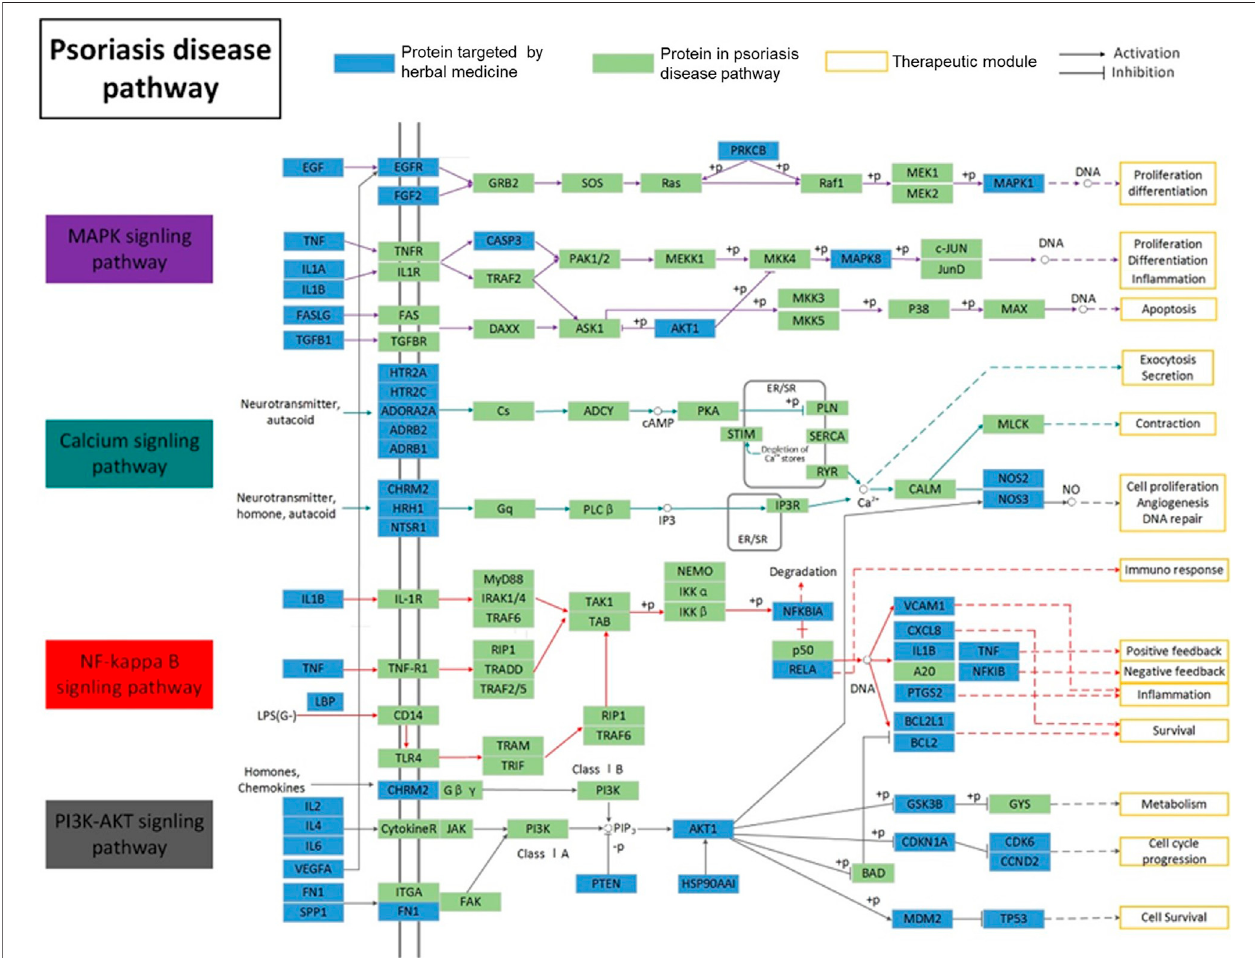
FIGURE 2 | Distribution of target proteins of LXJD formula in integrated psoriasis-related pathways, which includes the MAPK, calcium, NF- κ B, and PI3K/AKT signaling pathways.s